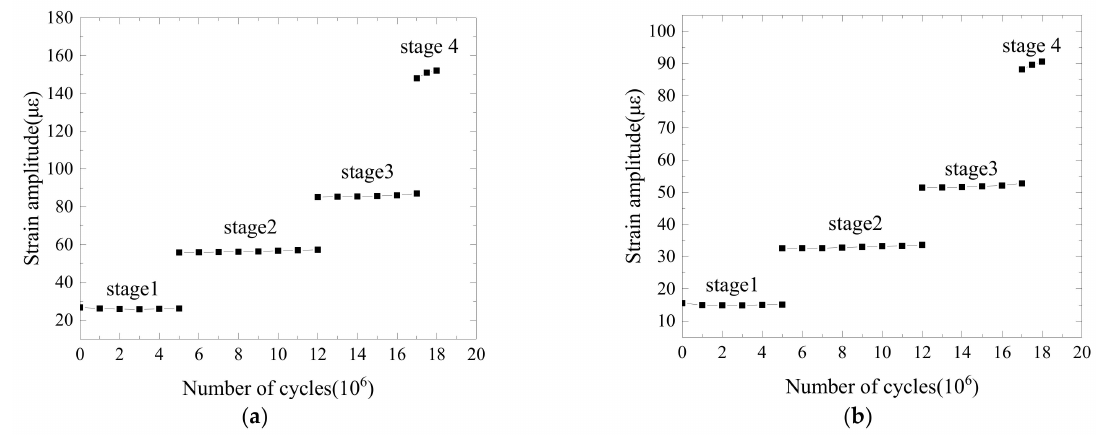
Figure 4. Strain amplitude curve of steel bar: ( a ) L/2 section; ( b ) L/4